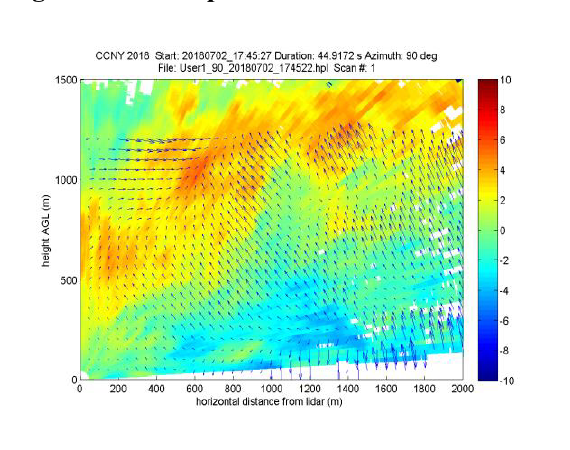
Fig. 8b Halo Streamline RHI output 13:45